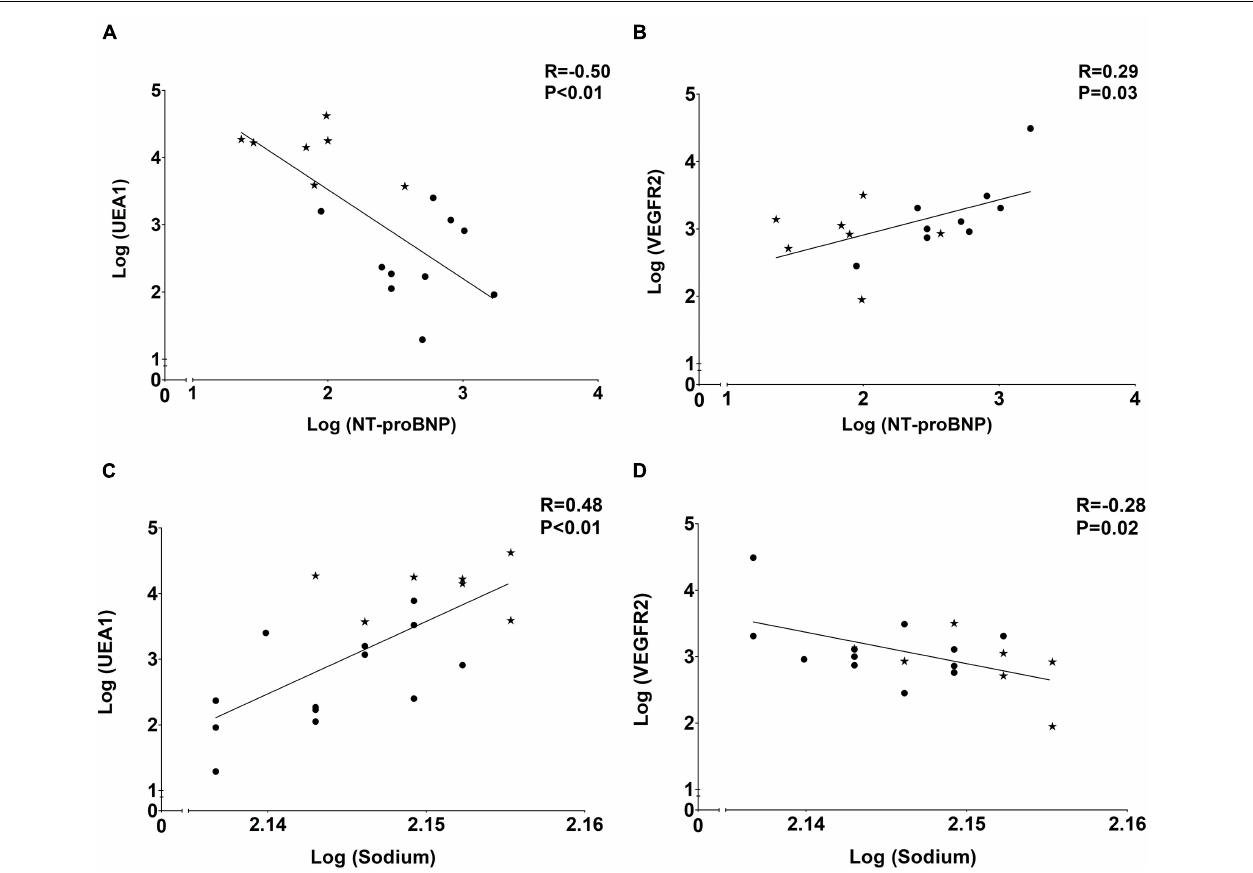
FIGURE 5 | Associations of plasma volume markerswith tissue endothelial markers. (A) Negative association of eGC marker UEA1 and volume marker NT-proBNP. (B) Positive association of endothelial marker VEGFR2 and volume marker NT-proBNP. (C) Positive association of eGC marker UEA1 and volume marker sodium. (D) Negative association of endothelial marker VEGFR2 and volume marker sodium. Dots represent CKD5 patients and stars indicate